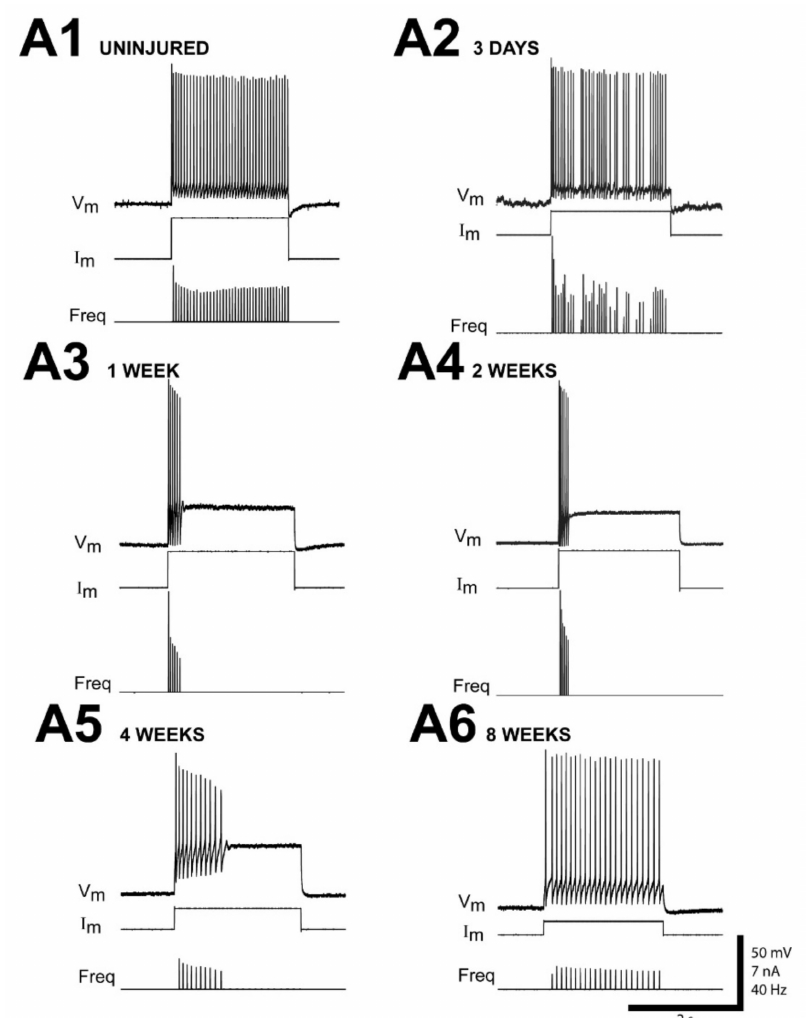
Figure 2. Examples of time course of altered firing patterns for RS neurons following right spinal cord HTs at 10% BL (see Figure 1B). Membrane potential (V m ), injected current (I m ), and instantaneous firing frequency (Freq). ( A1 ) Smooth continuous repetitive firing of an uninjured (left) “B4” large, identified RS neuron (Müller cell, see Figure 1A,B; 2 wk recovery time) in response to a 2.0 s depolarizing current pulse. ( A2 – A6 ) Repetitive firing patterns of injured (right) “B4” RS neurons from different animals at various recovery times in response to 2.0 s depolarizing current